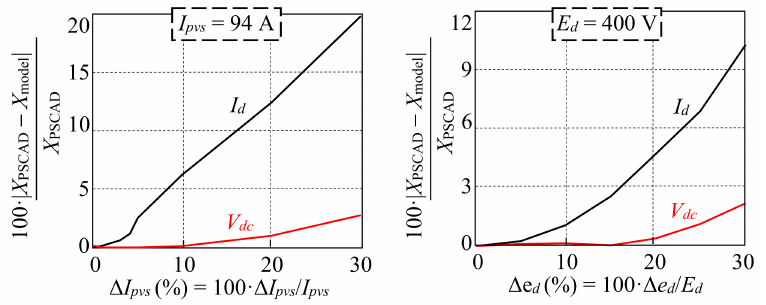
Figure 5. Validity study of the qZSI-PV system